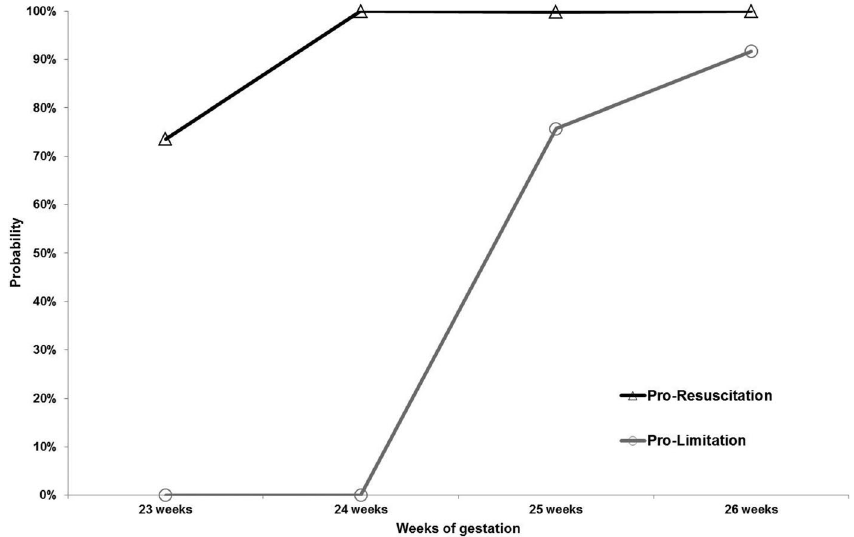
Figure 1- Probability of initiating positive pressure ventilation according to the latent class ( ‘ pro-resuscitation ’ and ‘ pro-limitation ’ ) of the survey respondents (N=559) and gestational